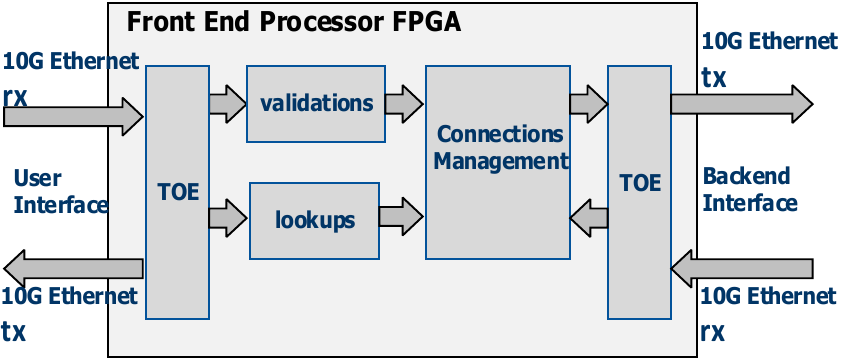
Figure 3. Block diagram of the front end processor FPGA.